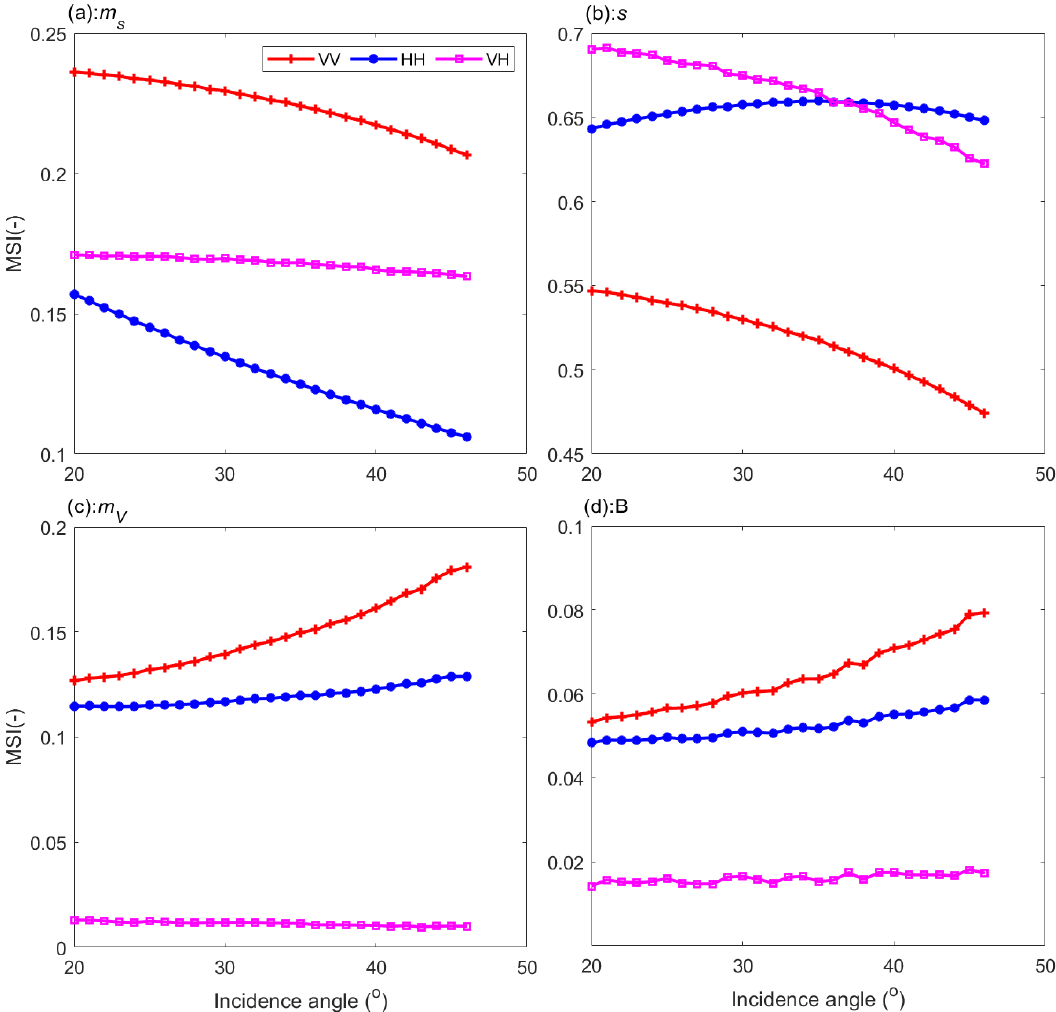
Figure 6. Variations of parameter MSIs with incidence angle and polarization.